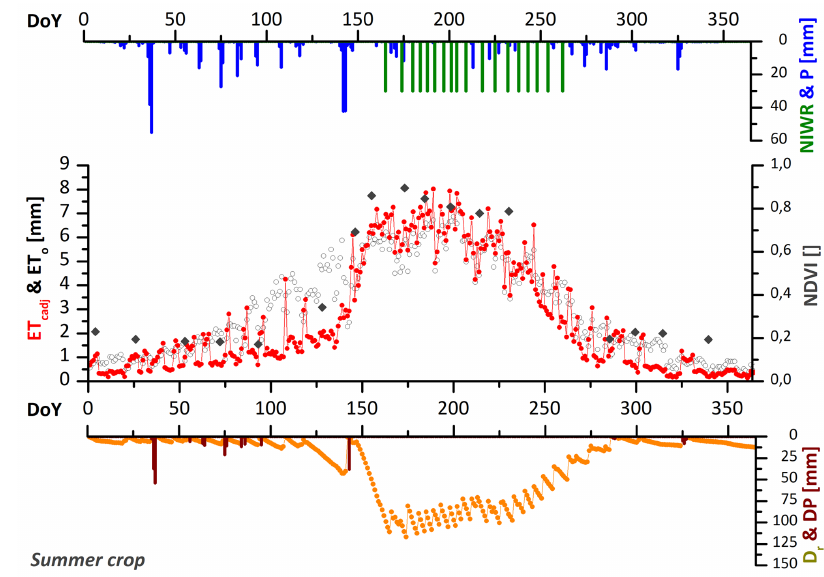
Figure 1. Daily evolution of the different components estimated by the RS-SWB computed by HidroMORE ® tool.